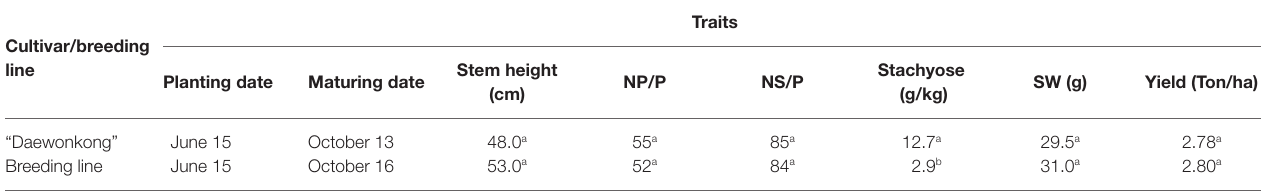
TABLE 3 | Quantitative characteristics of the cultivar (“Daewonkong”) and breeding line strain in field conditions during 2021.